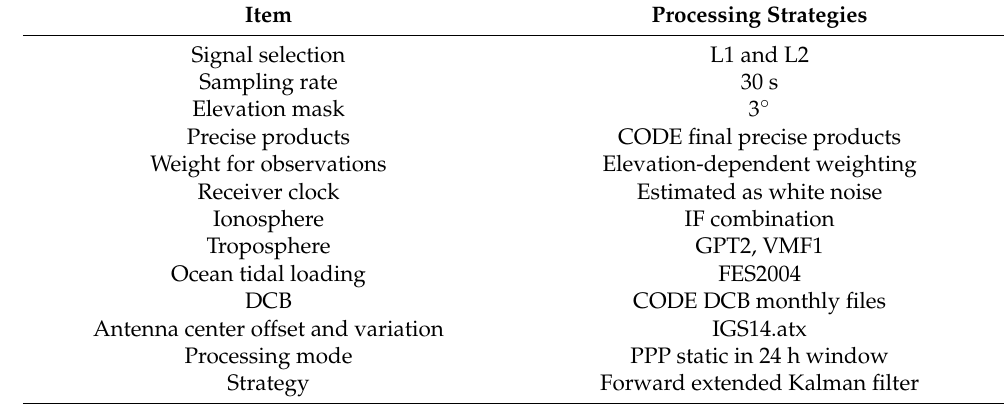
Table 1. The processing strategies of PPP.